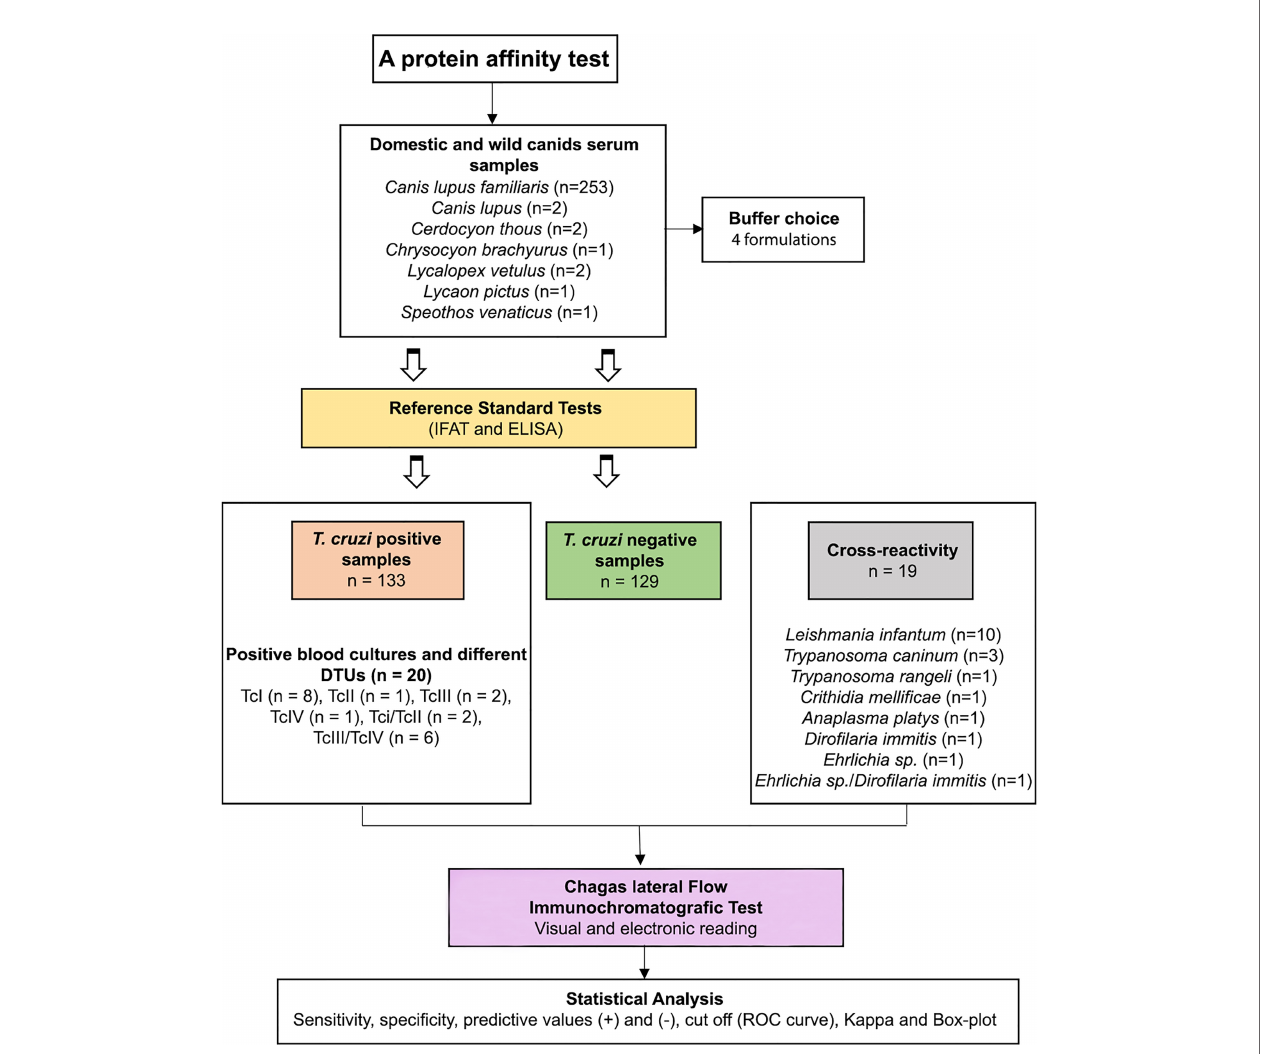
FIGURE 1 | Scheme showing the serum samples from wild and domestic canids with previous serological diagnosis (IFAT and ELISA) selected to compose the panel of positive and negative samples and serum samples with different parasitic infections used in the Chagas lateral fl ow immunochromatogra fi c test